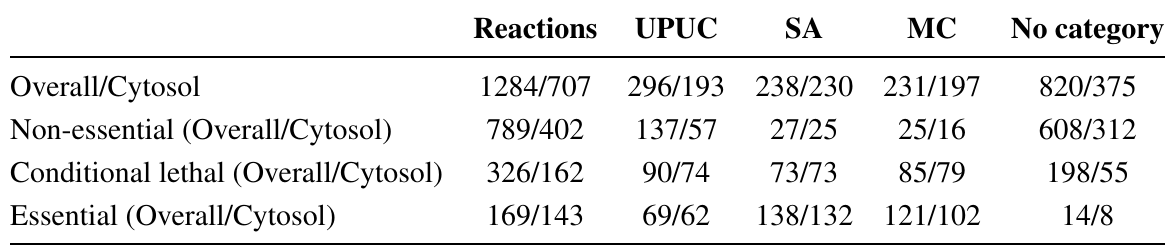
Table 1. Summarizing statistics of reaction categories and